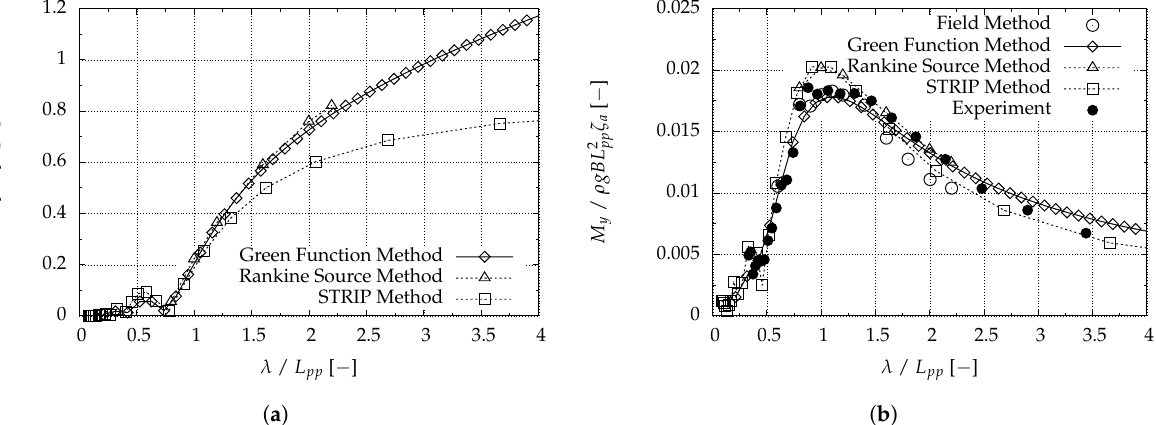
Figure 8. LNG carrier: computed and measured RAOs. ( a ) Surge motions ξ and ( b ) midship vertical bending moment M y (right). ρ is the water density, g the gravity constant, B the ship’s breadth and L pp the ship